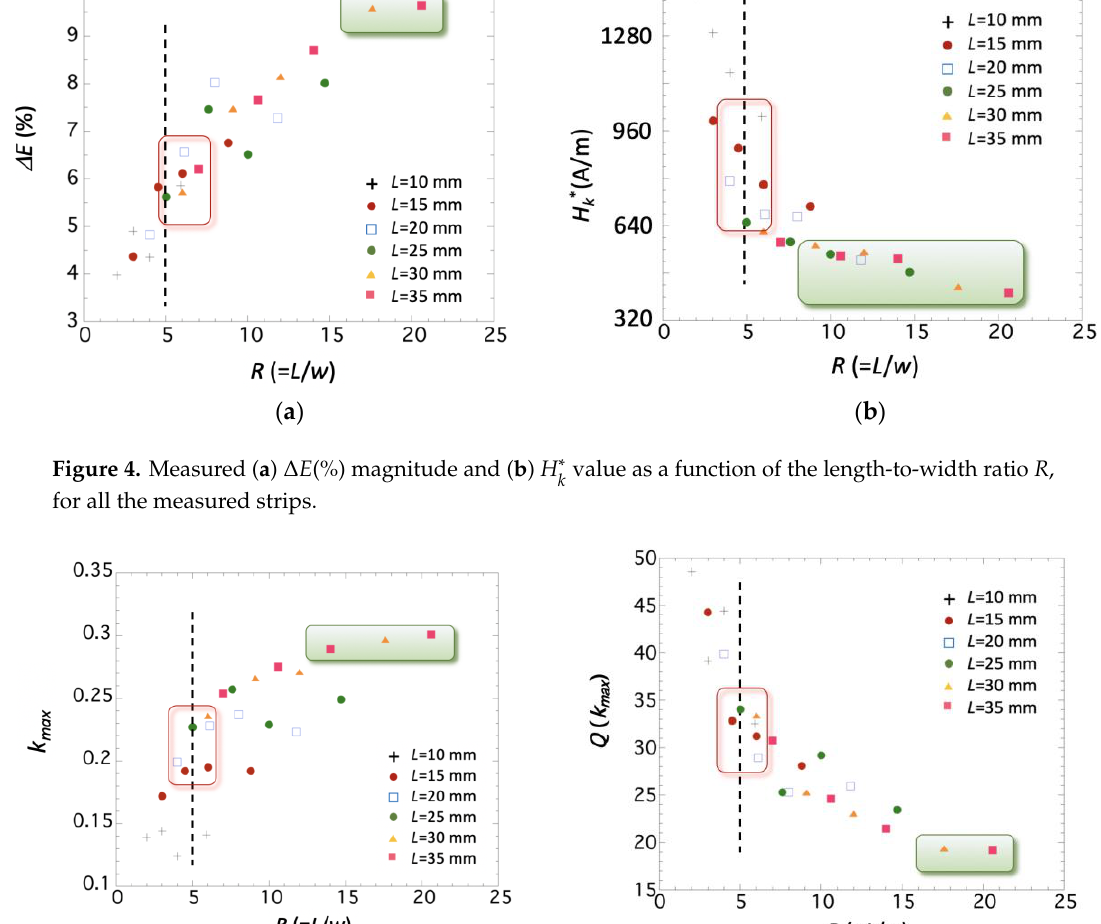
Figure 5. Measured ( a ) k max value and ( b ) Q ( k max ) value as a function of the length-to-width ratio R , for all the measured strips.